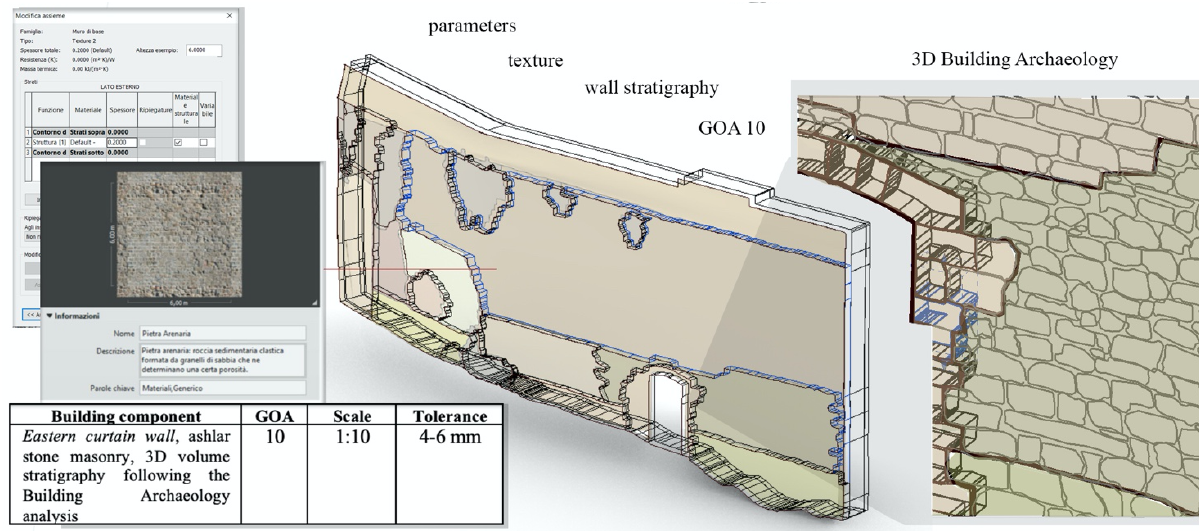
Figure 9. HBIM for Building Archaeology: wall stratigraphy and